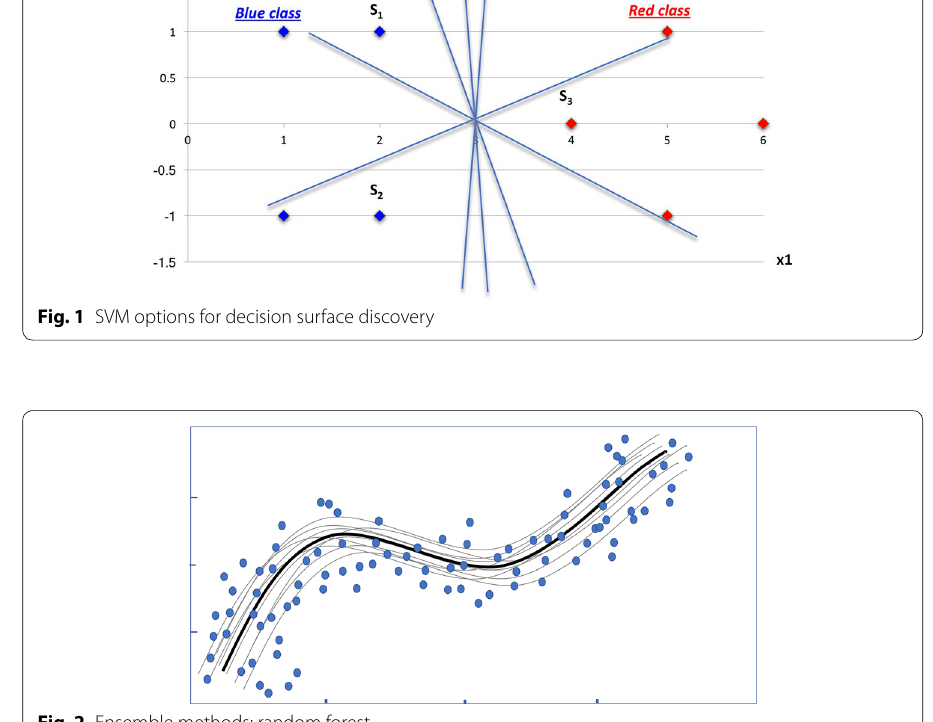
Fig. 2 Ensemble methods: random